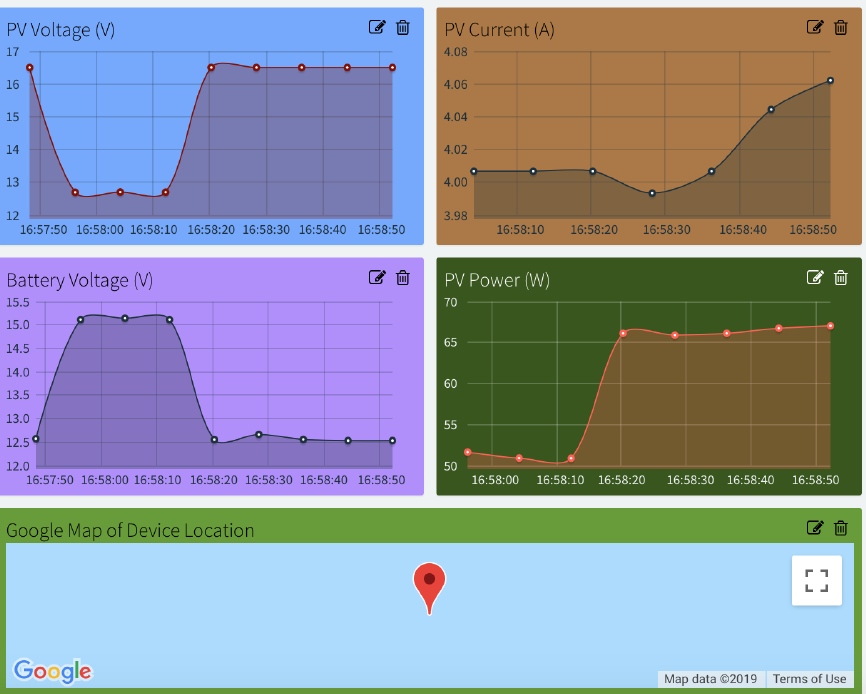
Figure 13. Created Dashboard (A) showing real-time data.